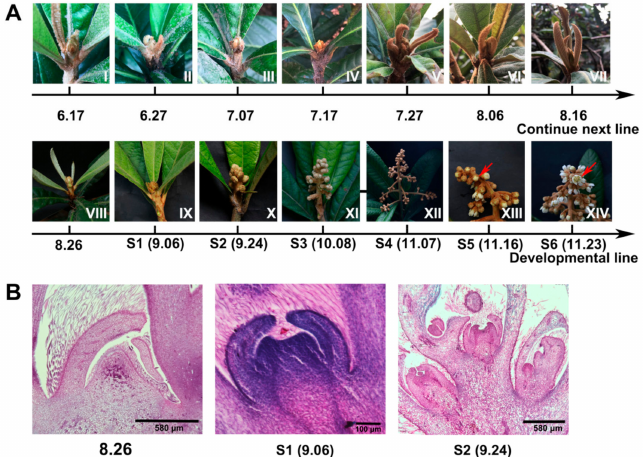
Figure 2. The morphology of tissues from June 17th to blooming. ( A ) June 17th to November 23th indicated the date for collecting apical buds. S1–S6 indicated the di ff erent stages of flowering development. S1: Floral meristems initiation. S2: Rapid panicle elongation. S3: Visible floral buds.